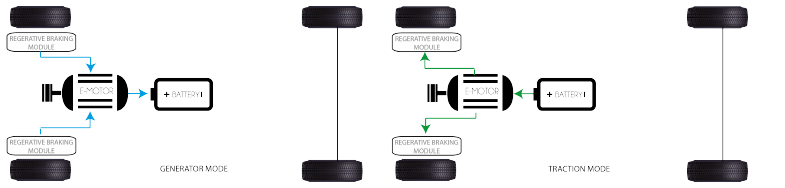
Figure 4. The configuration of an RB-ER. Energy flow: left generator mode and right traction mode.